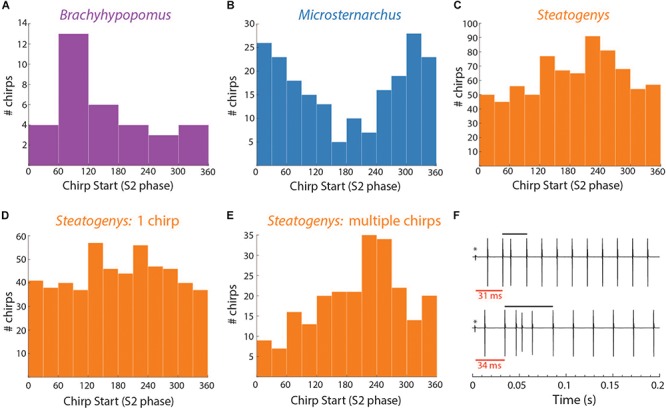
Distributions of chirp starts in terms of S2 phase (A–E) and examples of early latency chirps in Steatogenys
(F). (A–C) Overall distribution of mean chirp starting phases for Brachyhypopomus, Microsternarchus, and Steatogenys. (D,E) The distribution of chirp phase angles in Steatogenys subdivided by trials that contain only a single chirp (D) vs. the distribution of chirp phase angles in trials where there is more than one chirp (E), showing a significant concentration of phase angles around 240°. (F) Examples of short latency chirps in Steatogenys. For illustrative purposes, the first S2 stimulus artifact was not digitally removed from these records (∗). The red bars show the latency from the first S2 to the start of the first chirp intervals. Black bars indicate the total chirp duration.